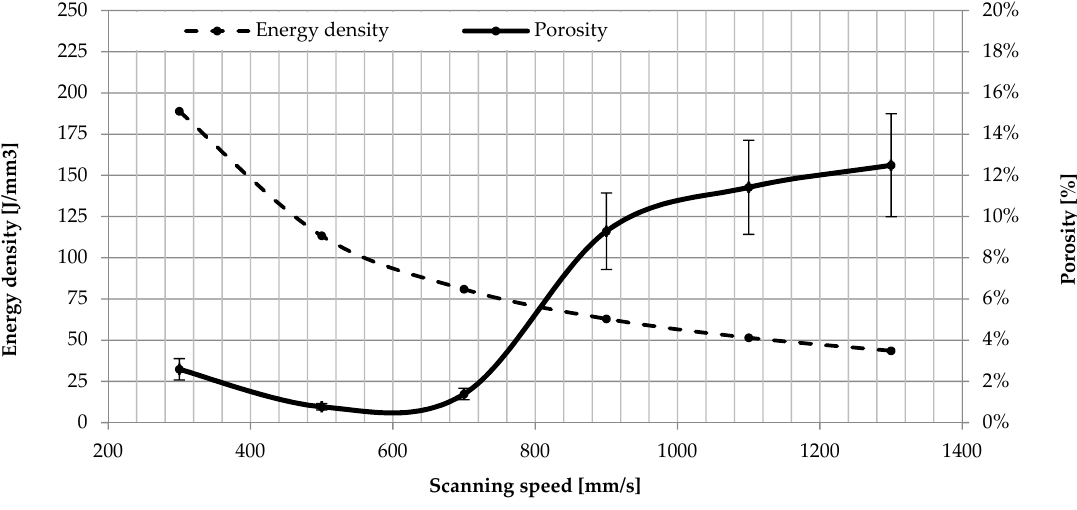
Figure 3. The influence of scanning speed and energy density on the porosity.